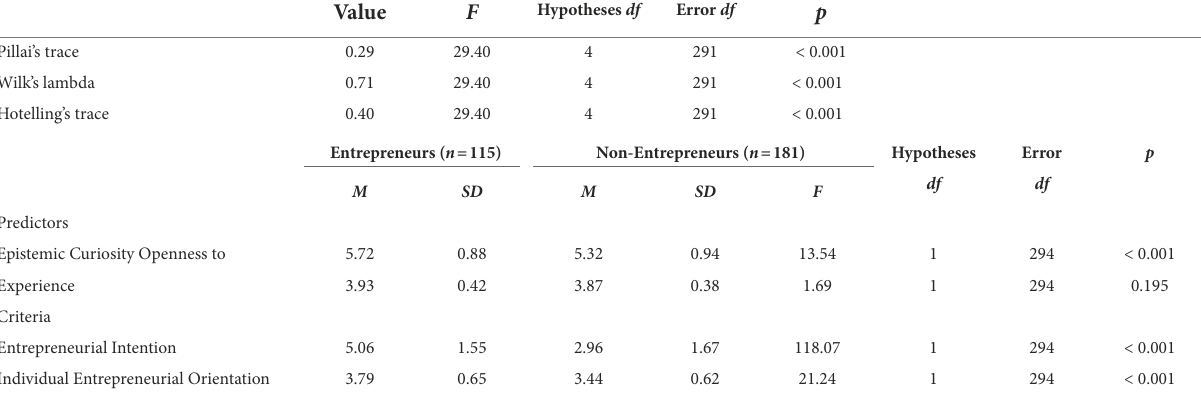
TABLE 3 One-way MANOVA results for group differences between entrepreneurs and non-entrepreneurs.